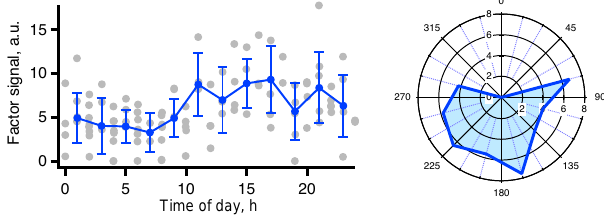
Figure 8. (a) Time series of PMF factor signals. Also denoted in the graph are the periods for which HYSPLIT back trajectories are calculated. (b) 12h back trajectories calculated using HYSPLIT (Draxler and Rolph,